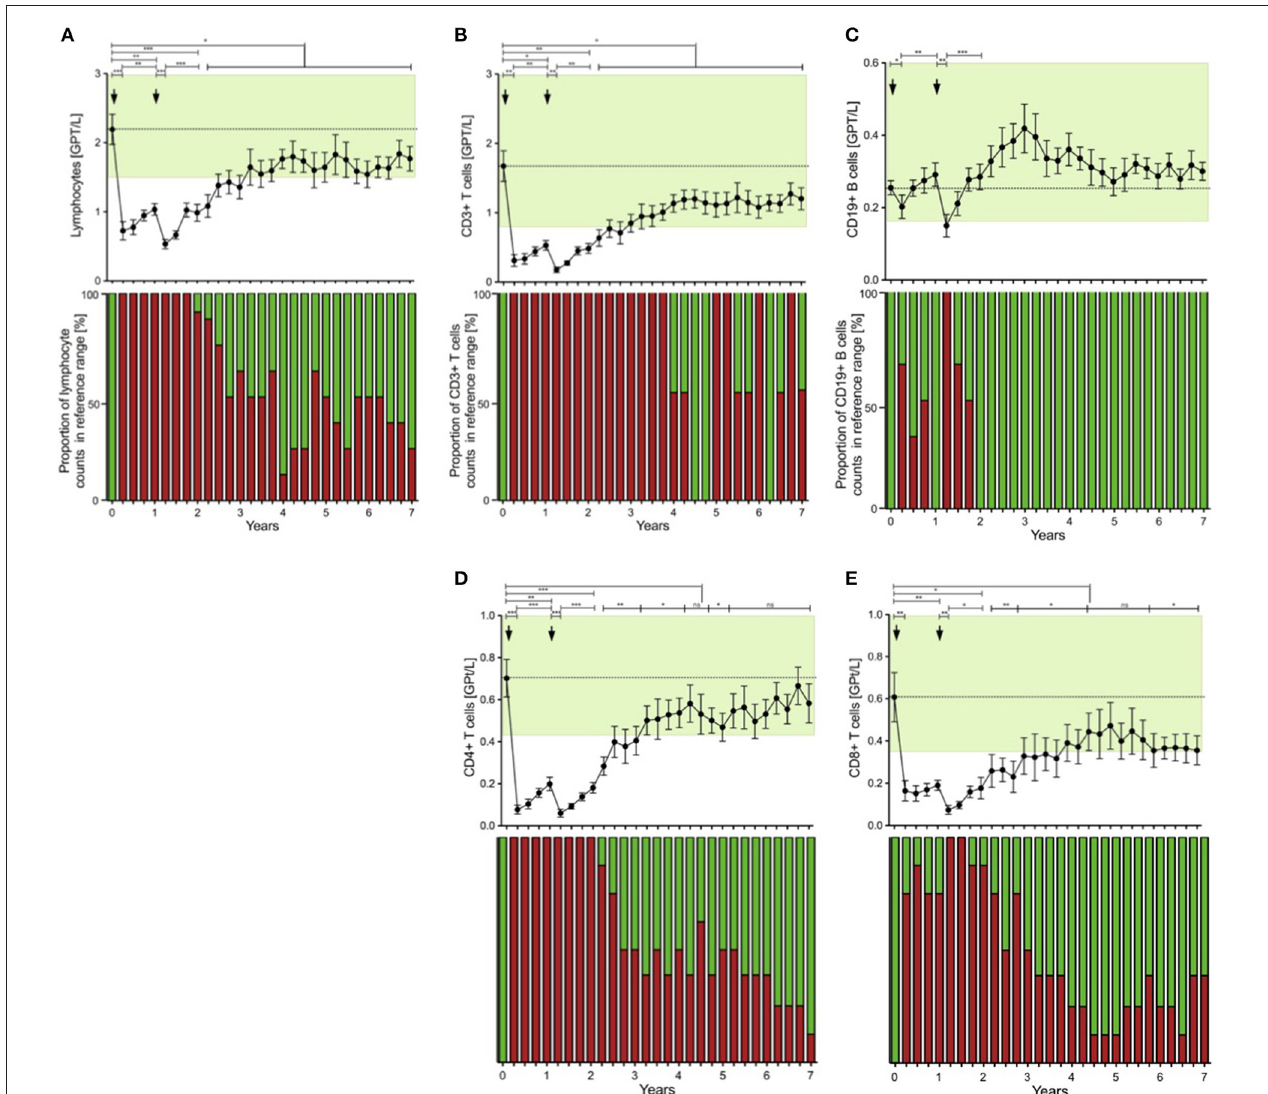
FIGURE 2 | Distribution of peripheral lymphocyte subsets of patients with stable disease course after 1st and 2nd ATZ (complete-responder). Distribution of absolute count of lymphocytes (A) , CD3+ T cells (B) , CD19+ B cells (C) , CD4+ T cells (D) and CD8+ T cells (E) before (0 years) and up to 7 years follow up are depicted. Mean values + / − SD of lymphocytes and its subsets at each of the 3 monthly evaluations are shown. Reference ranges are marked by pastel green color and baseline values are highlighted by the dotted line. Additionally, proportion of patients that reached values in reference range (green) vs. not (red) are presented for each individual time point and immune cell subtype. Asterisks indicate a statistically significant difference (* p < 0.05, ** p < 0.01, *** p < 0.001).